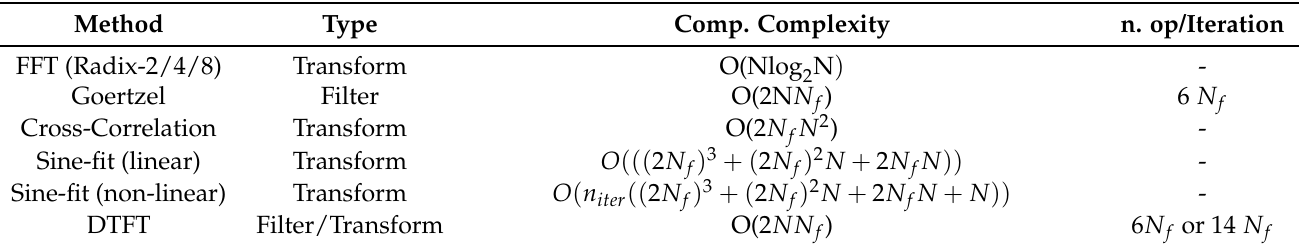
Figure 2. ( a ) Time complexity of DTFT/Goertzel vs. FFT as a function of N and N f . ( b ) Time complexity of Sine-fit (linear) vs. FFT as a function of N and N f . Table 1. Comparison between Computation Complexity of Several Methods of AC signal analysis per Number of Samples and Number of Frequency